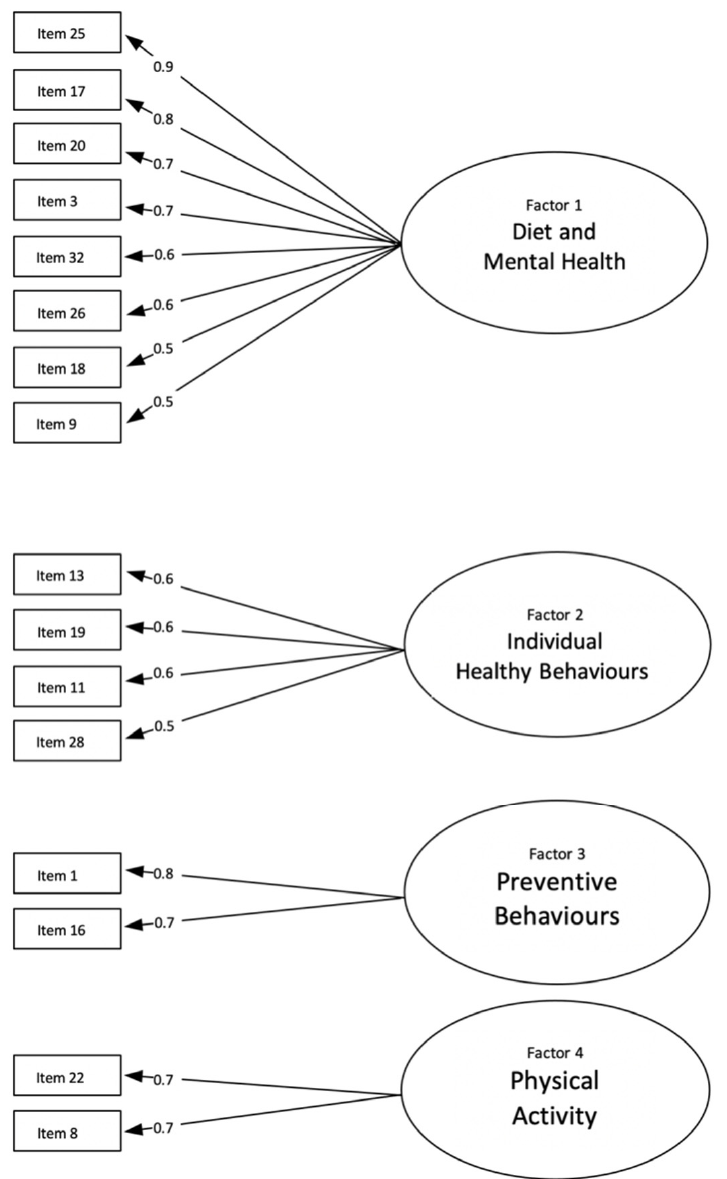
Figure 3. EFA of the HBS items.